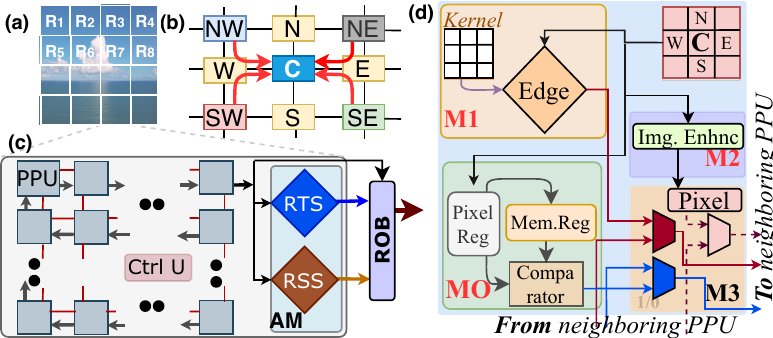
Figure 5. ( a ) Block diagram of an RPU at the Attention-based preprocessing layer (APL) ( b ) Parallel image acquisition process in the sensor to initiate processing ( c ) Block diagram of a RPU ( d ) Block diagram of the